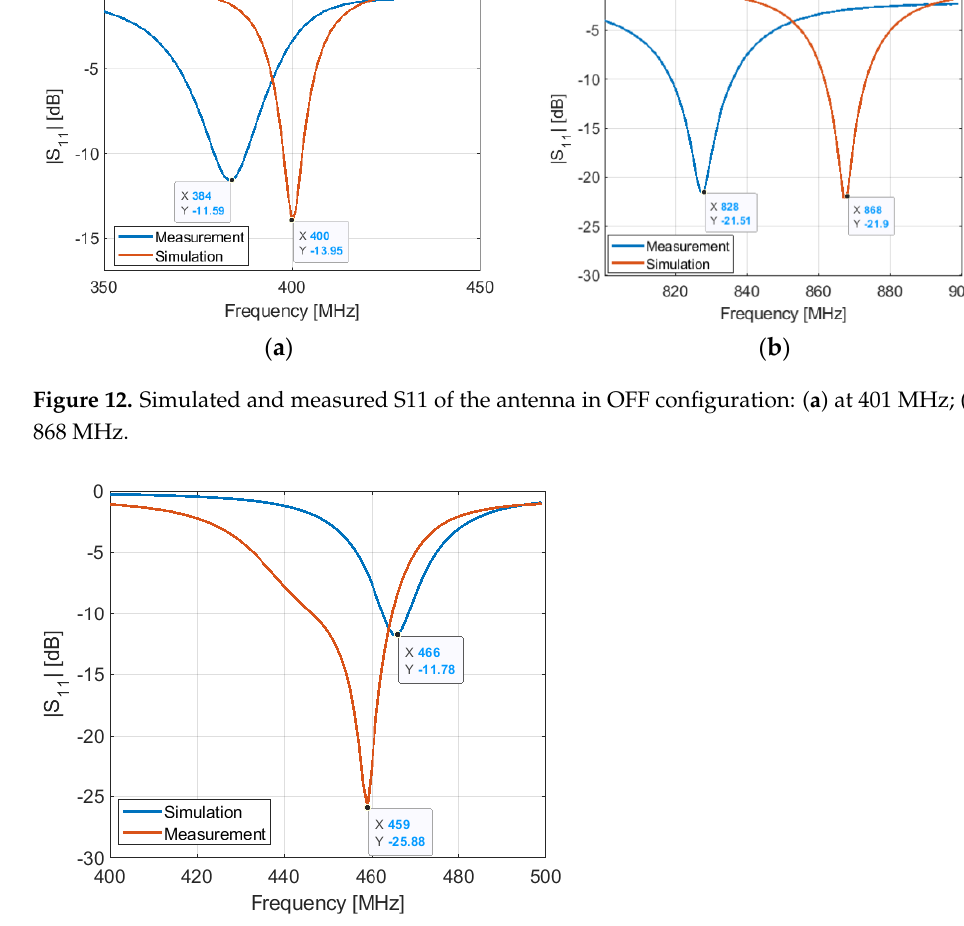
Figure 13. Simulated and measured S11 of the antenna in ON configuration.